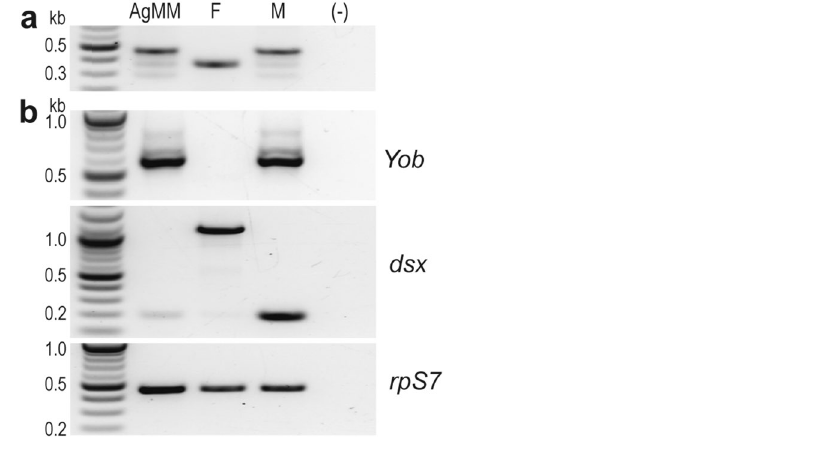
Figure 2. Molecular characterisation of the AgMM cell line. ( a ) Sexing PCR shows male origin and presence of the Y chromosome in the AgMM cells. ( b ) RT-PCR analysis of transcription and splicing pattern of the sex determination genes Yob and dsx . F, female, and M, male samples were used for comparison; (–), no template control. Ribosomal protein S7 (rpS7) transcript levels were used as a gel loading control.